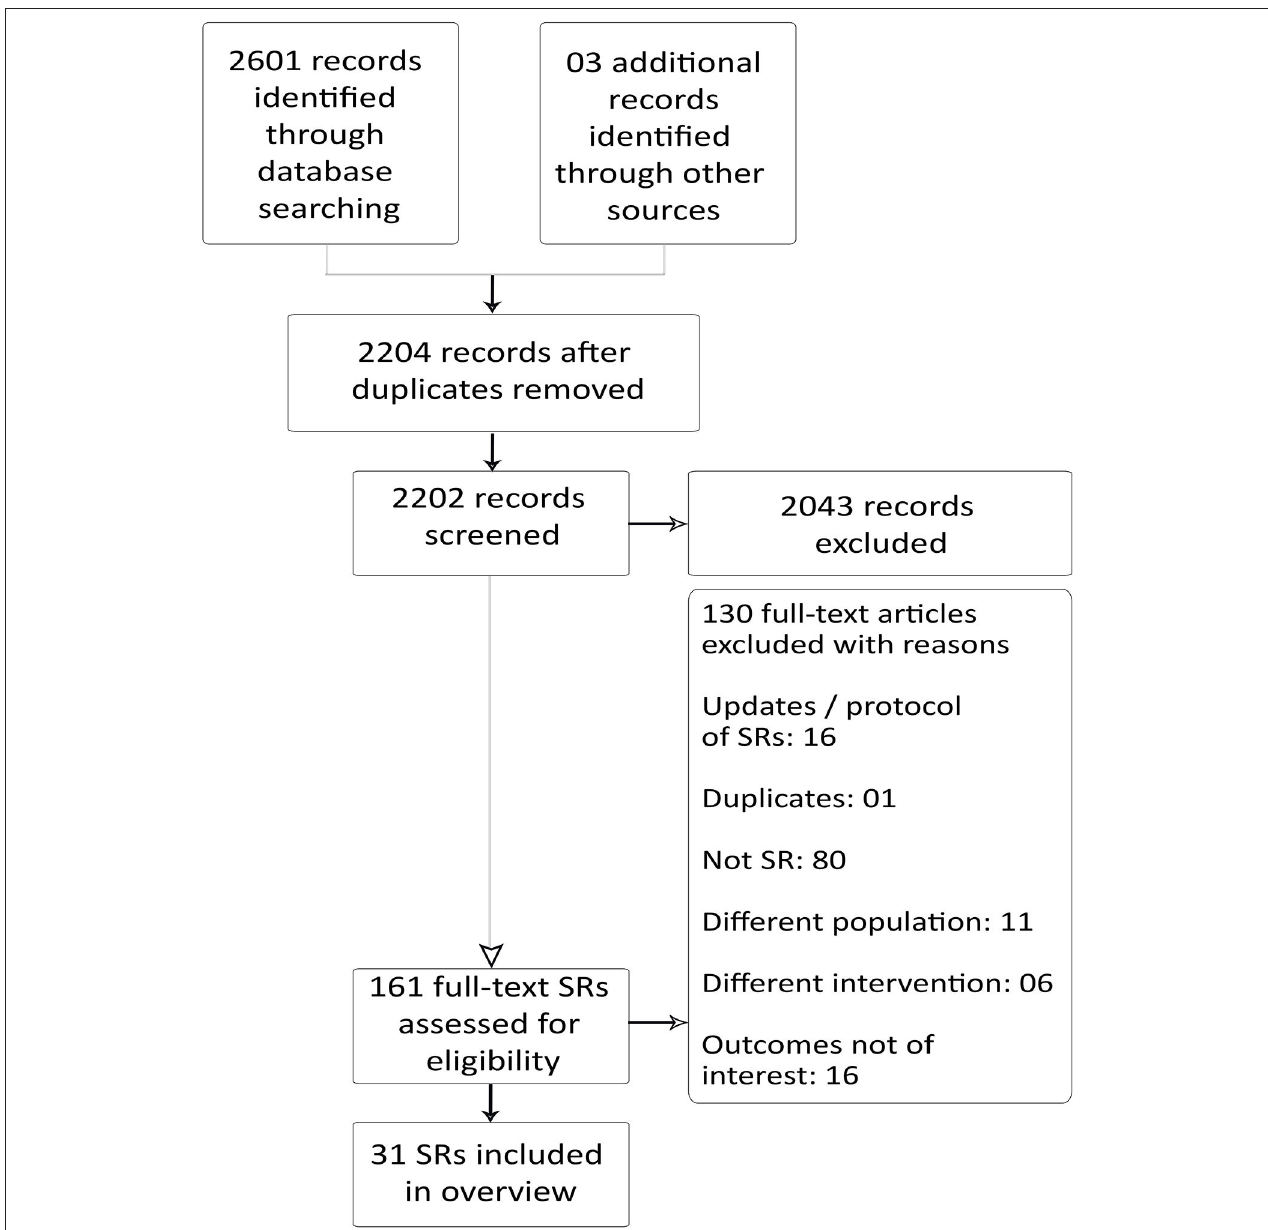
FIGURE 1 | Preferred reporting items for SR and meta-analysis: the PRISMA flow diagram for inclusion and exclusion of